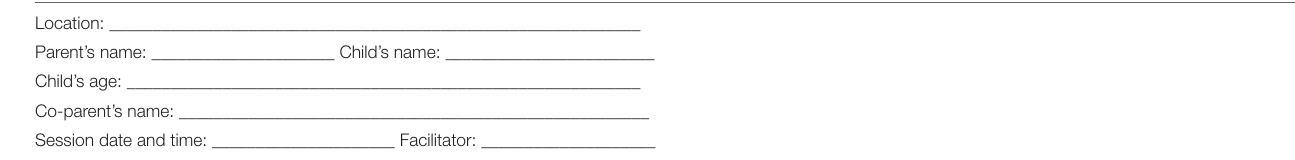
TABLE 4 | ATTACH TM fidelity checklist for triadic